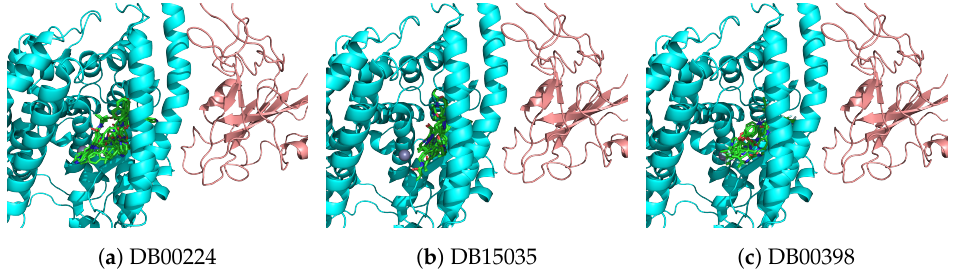
Figure 4. Top 9 lowest energy poses for compounds with high scores in both SSnet and smina of biological interest to CoVID-19. Panel ( a ): Indinavir binding poses. Panel ( b ): Zanubrutinib binding poses. Panel ( c ): Sorafenib binding